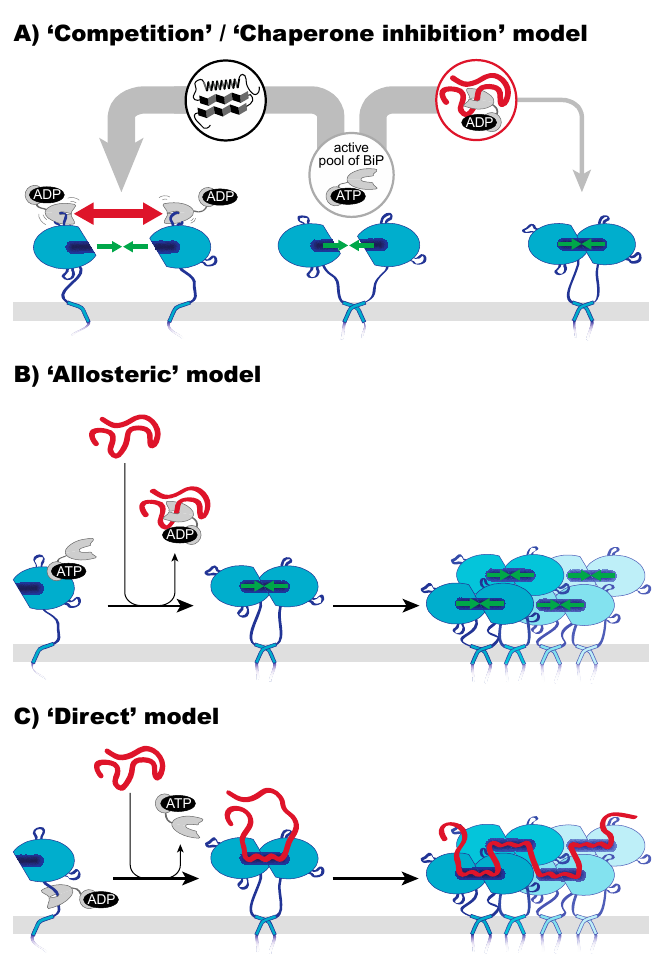
Figure 2. Three models of how IRE1 α might sense ER stress. Currently, three models of IRE1 α activation by unfolded proteins are being discussed. ( A ) The ‘competition’ or ‘chaperone inhibition’ model attributes a more passive role to the UPR transducer IRE1 α and suggests that BiP acts as the true sensor of ER stress. The chaperone BiP associates dynamically with IRE1 α molecules in the absence of stress and counteracts the intrinsic tendency of IRE1 α to dimerize/oligomerize. Upon ER stress BiP associates with unfolded/misfolded proteins, thereby dissociating from IRE1 α and enabling its dimerization and activation. ( B ) The ‘allosteric’ model suggests that BiP’s nucleotide binding domain (NBD) associates with IRE1 α to sterically block its dimerization/oligomerization. The accumulation of unfolded/misfolded proteins in the lumen of the ER is sensed by BiP’s substrate binding domain (SBD). The binding of unfolded proteins to the open SBD induces a conformational change in BiP and the dissociation from IRE1 α . ( C ) The ‘direct’ model suggests a direct binding of unfolded/misfolded proteins to the ER ‐ luminal domain of IRE1 α . Unfolded proteins are thought to bind to peptide ‐ binding pockets across the dimer interface of IRE1 α ’s ER ‐ luminal domain. Unfolded proteins stabilize dimeric and oligomeric assemblies of IRE1 α , and therefore serve as activating ligands triggering the UPR.